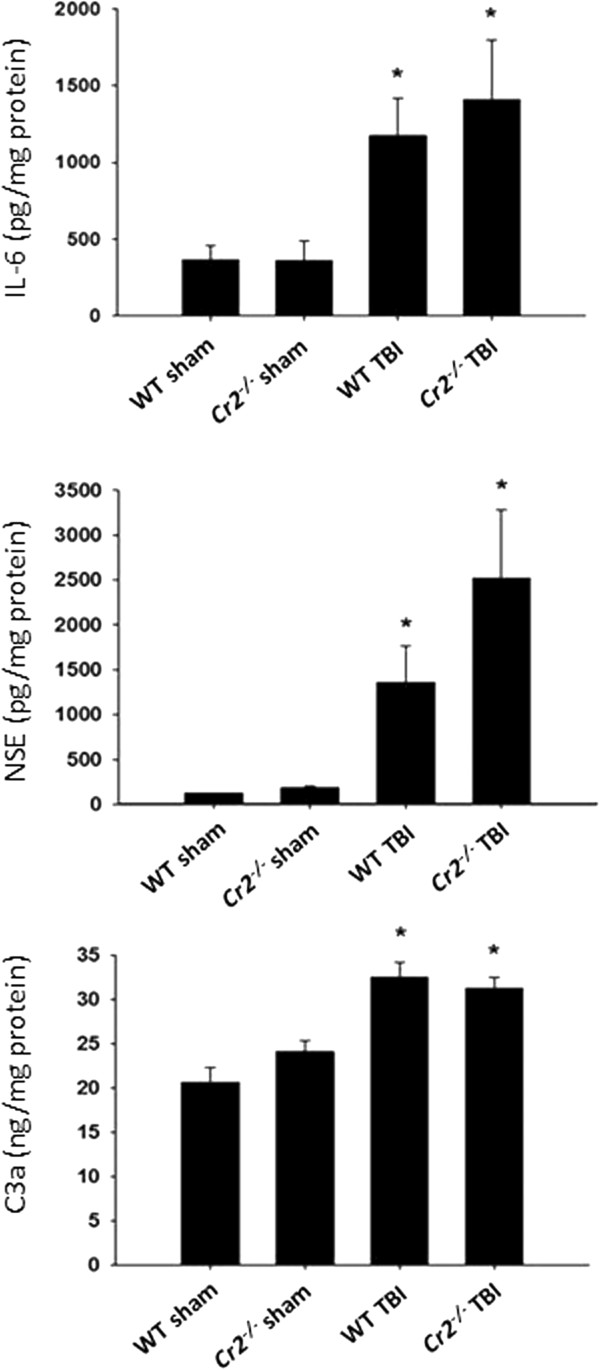
Peripheral levels of selected biomarkers and inflammatory mediators in wild-type (WT) and Cr2-/- mice at 24 hours after closed head injury or sham surgery. Serum and plasma samples were analyzed by mouse-specific ELISA. Final mediator concentrations were normalized by total protein content of the samples, as described in the Materials and methods section. Head-injured mice showed a significant increase in mediator levels at 24 hours, compared to sham-injured animals (*P <0.05). However, there was no difference in concentrations between head-injured WT and Cr2-/- mice. Data are shown as mean values ± SD and are representative of n = 22 WT and n = 13 Cr2-/- mice.